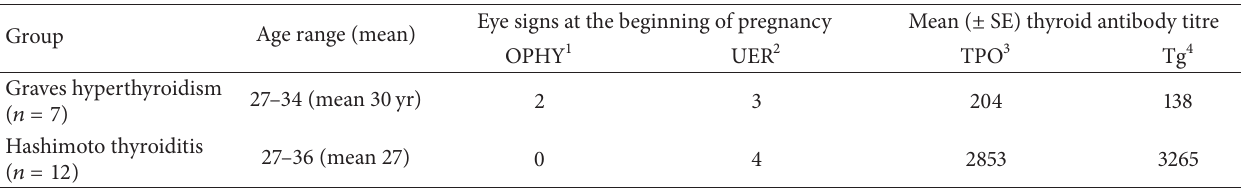
Table 1: Demographics, basal thyroid antibody titres, and eye signs at the beginning of pregnancy in women with Graves’ hyperthyroidism and Hashimoto’s